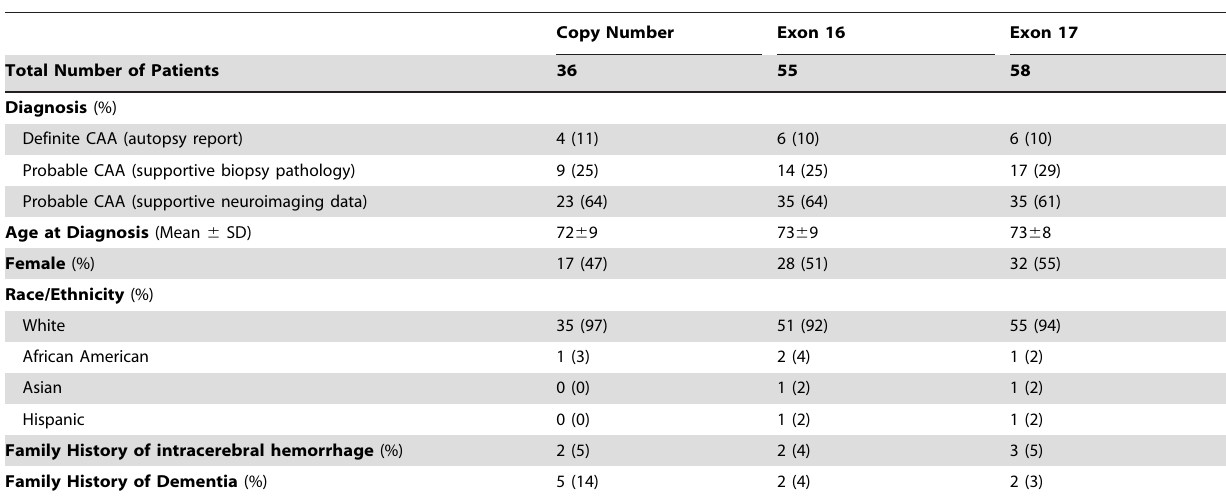
Table 2. Characteristics of Patients with Sporadic